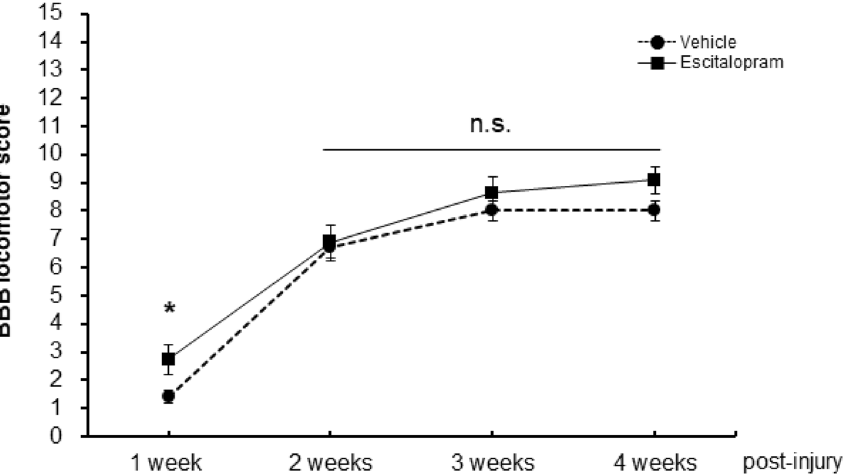
Figure 6. Evaluation of hind limb locomotor scoring. The graph shows the weekly Basso, Beattie, and Bresnahan locomotor score of each group (dashed line with round plots: vehicle-treated group, black line with rectangular plots: escitalopram-treated group). * P < 0.05, n.s.